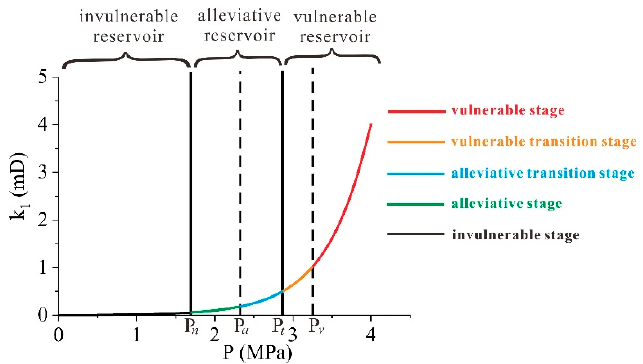
Figure 3. Reservoir classification and corresponding demarcation points in the single-phase water flow stage.